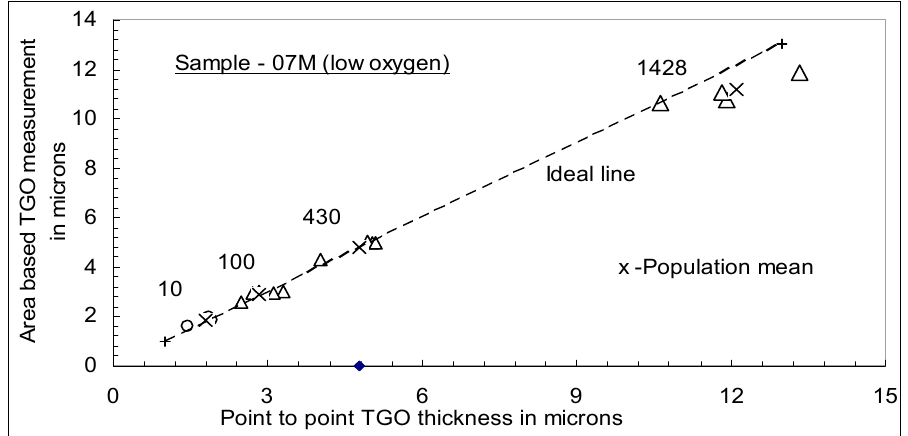
Figure 2. Mean TGO thickness data obtained by two methods scatter around the ideal line (shown as broken line) for low oxygen pressure samples (M07—the cycle numbers are shown). x represents mean of all measurements for each thermal cycle and ∆ represents mean of data from individual images.